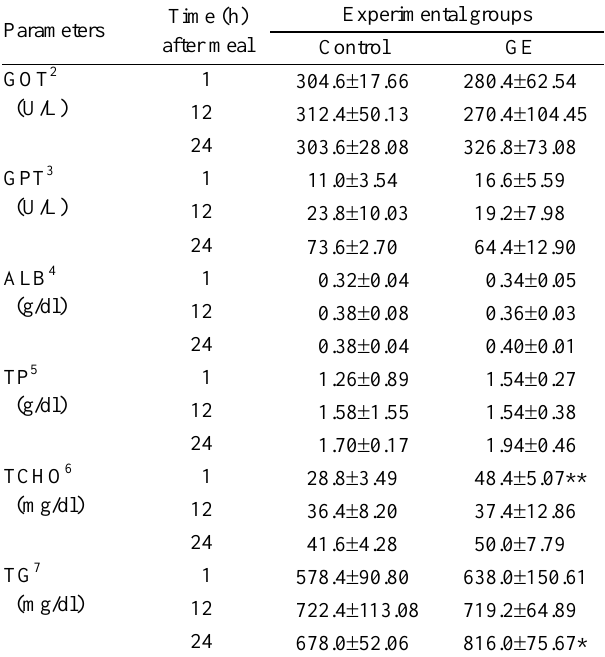
Experimental groups